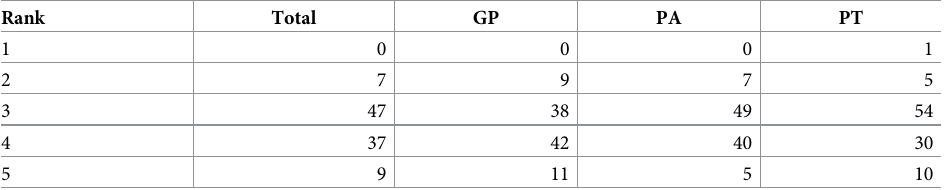
Table 1. Participant self-assessment on information seeking on cough and bronchial conditions; data are shown as % of responders (rounded to full number; based on 303 participants including 102 GPs, 101 PAs and 100 PTs) rating on a scale from 1 (never) to 5 (very